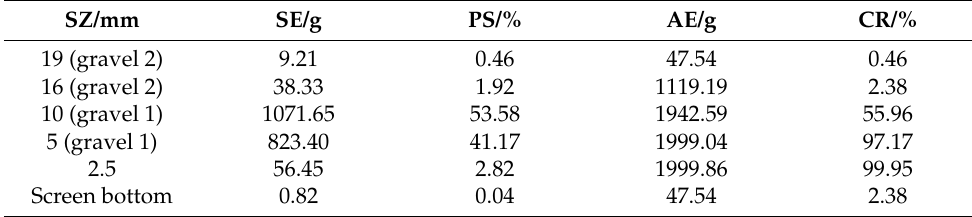
Table 2. Granulometry test for coarse aggregate.